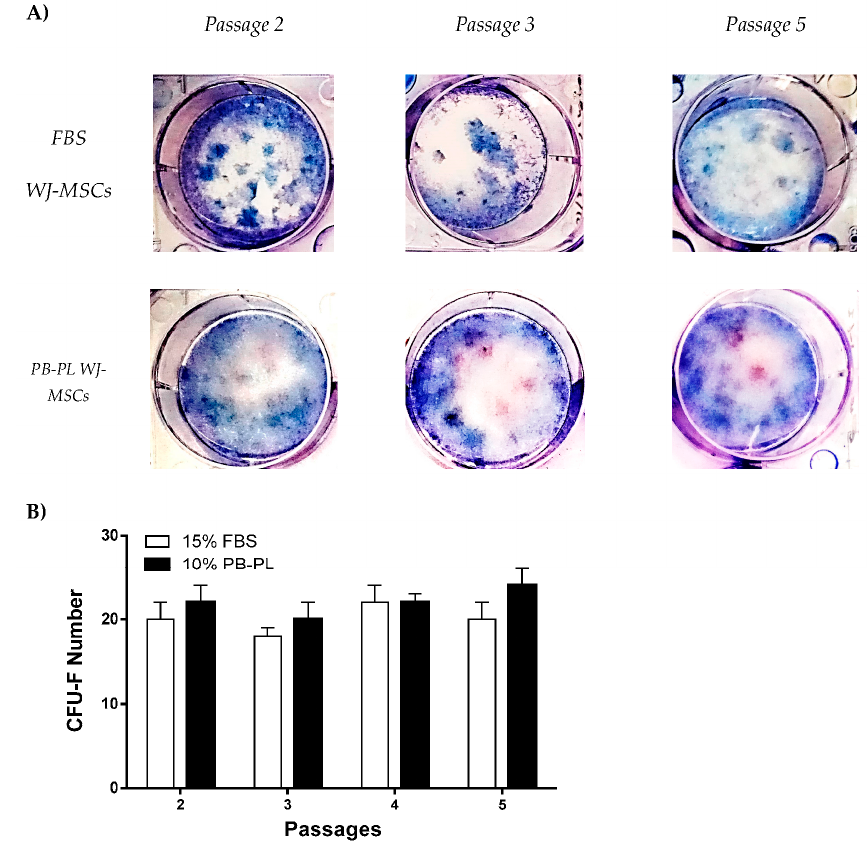
Figure 5. Colony Forming Unit-Fibroblast assay of FBS and PB-PL expanded WJ-MSCs. ( A ) Representable images of CFU-F at passages 2,3 and 5stained with Giemsa ( B ) The CFU-F assay was performed at passages 2,3,4 and 5 where no statistical significant difference was observed between FBS and PB-PL expanded WJ-MSCs.